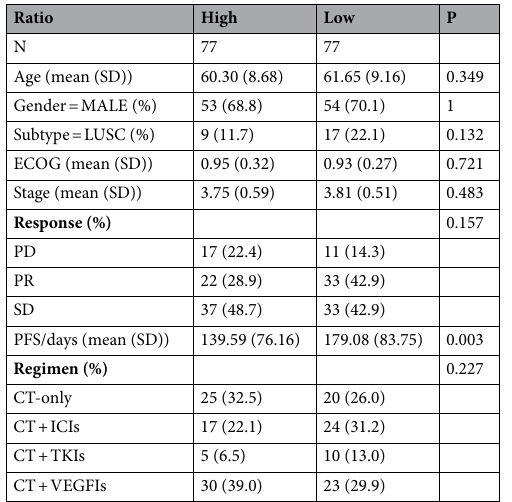
Table 2. Comparisons between Ratio_high group and Ratio_low